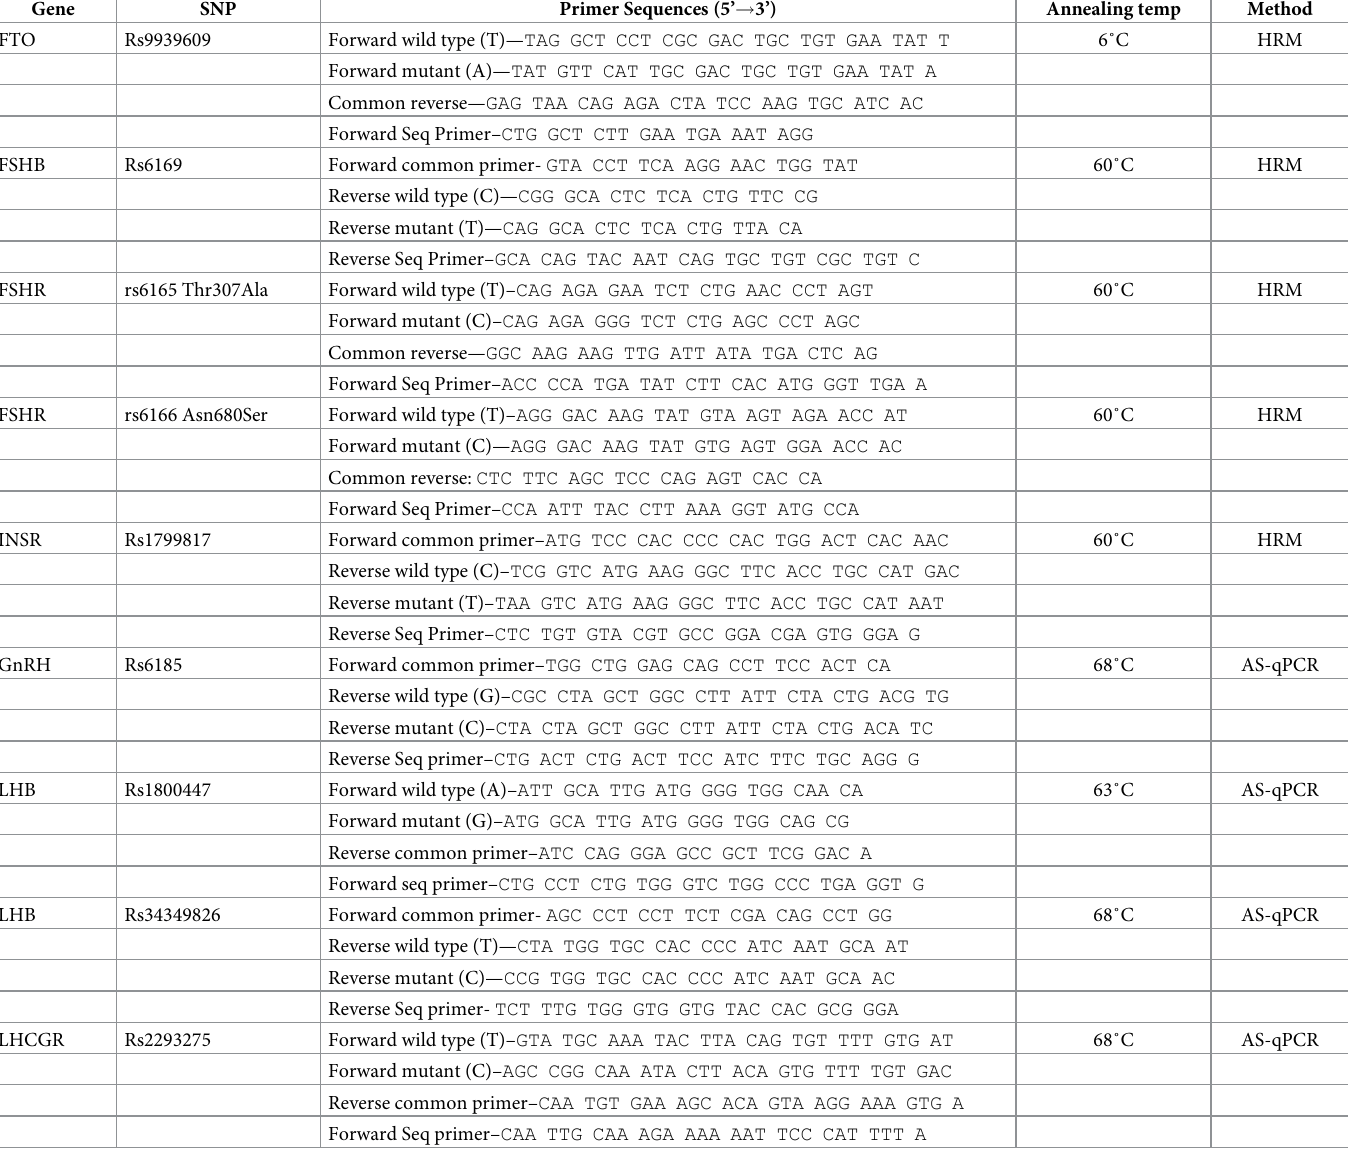
Table 1. Primer sequences used for HRM and Allele specific real time quantitative PCR. Gene